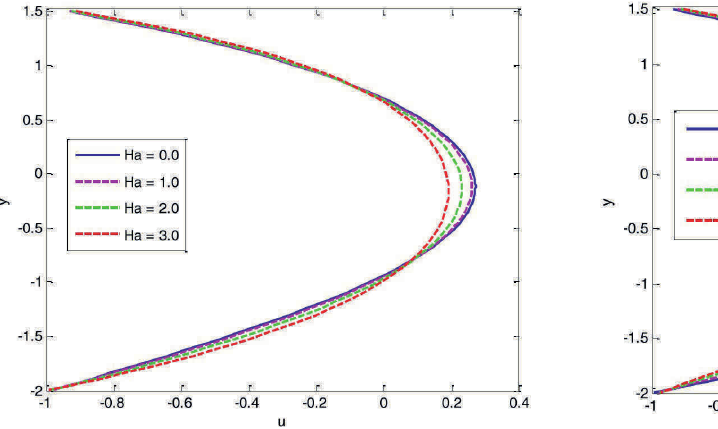
Fig. 7: Impact of Deborah number Γ on velocity.